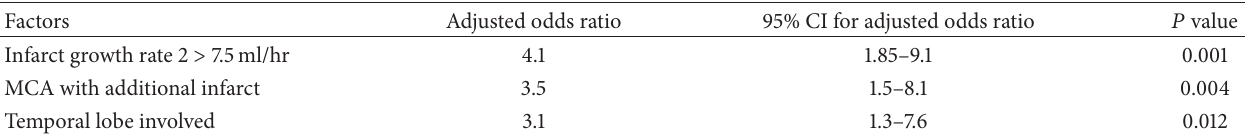
Table 3: Multivariate analysis of factors impacting time to surgery, adjusted for Age, gender, HTN, DM, and dyslipidemia. Factors Adjusted odds ratio 95% CI for adjusted odds ratio Infarct growth rate 2 >